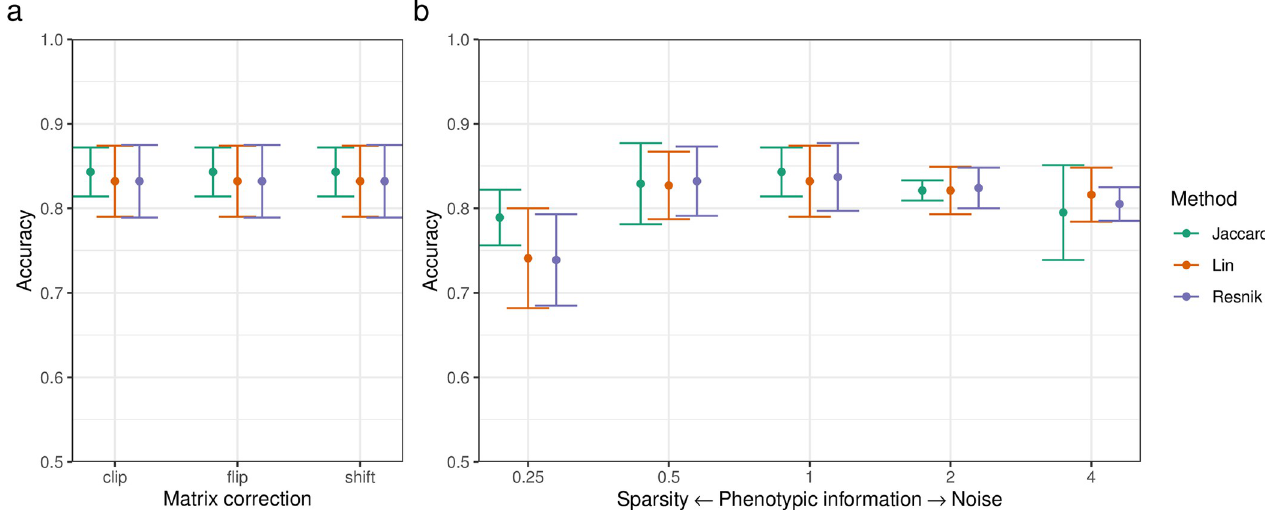
Fig 2. Phenotypic multi-task multi-kernel learning performs well across different similarity measures or matrix correction methods and is largely insensitive to sparse or noisy phenotypic information. a : Dot chart of MKL model mean accuracy and standard deviation for each similarity measure and methods for approximating the nearest PSD matrix. The Jaccard index does not require matrix correction but is shown for comparison. b : Dot chart of MKL model mean accuracy and standard deviation for each similarity measure across levels of simulated phenotypic sparsity and noise. Noise is shown as human phenotype ontology term ratio (e.g. noise ratio 0.25 removes 3 out of 4 terms from the set, while noise ratio 4 adds 3 random terms for each original term in the set).